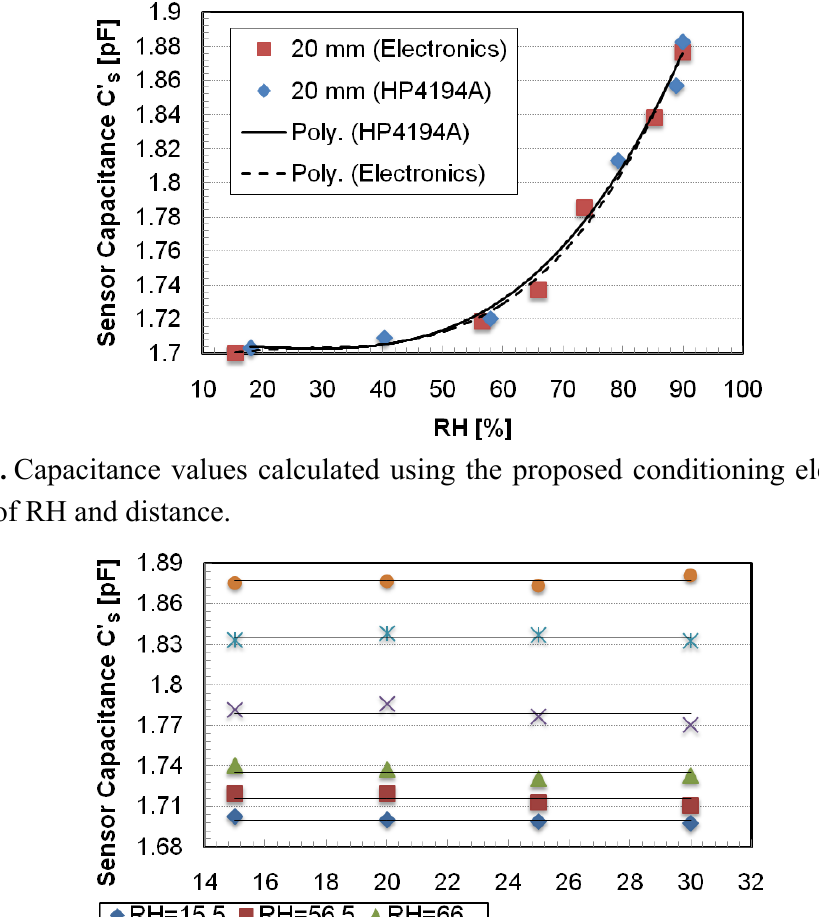
Figure 5. The calculated capacitance values as a function of RH and for different distance values.